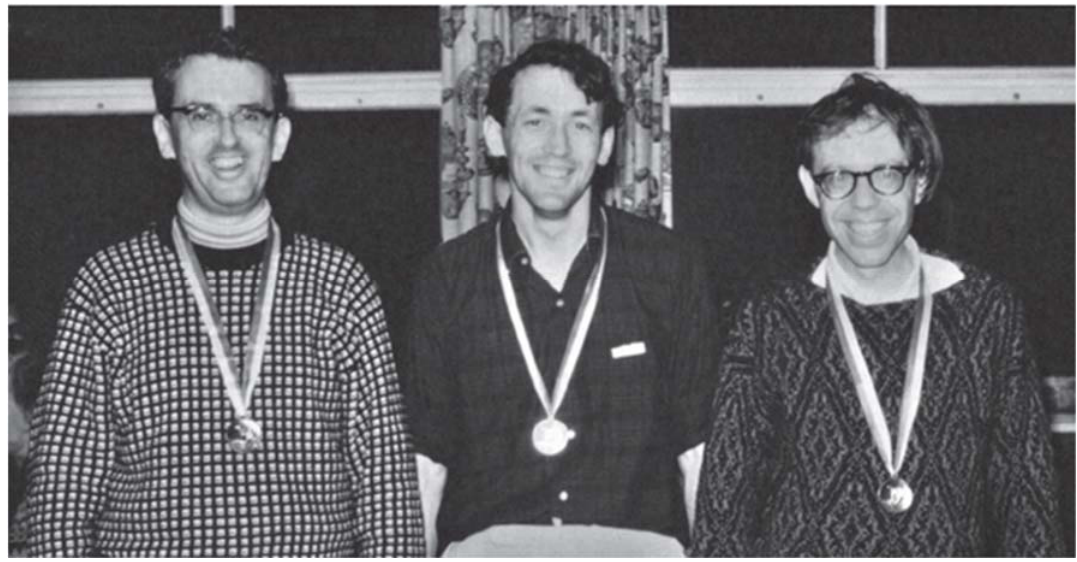
Figure 1. Michael won a bronze medal in a group beginner’s skiing competition at Hirschegg in 1966 [6].